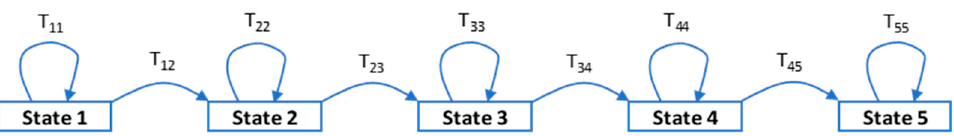
Figure 2. Five-states Markov process model for transformer future condition [24].